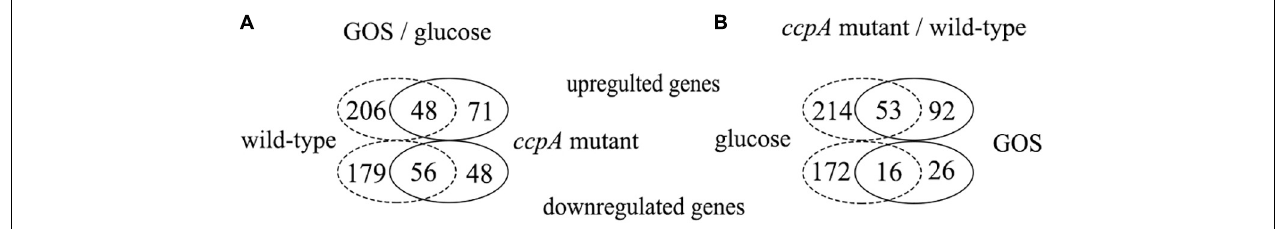
FIGURE 3 | Venn diagrams of the number of genes differentially expressed in the four pair-wise comparisons. (A) Number of genes differentially expressed in response to GOS compared with glucose of the wild-type (dotted line) and ccpA mutant (full line). (B) Number of genes differentially expressed in ccpA mutant compared to the wild-type strains, grown on glucose (dotted line) and GOS (full line).